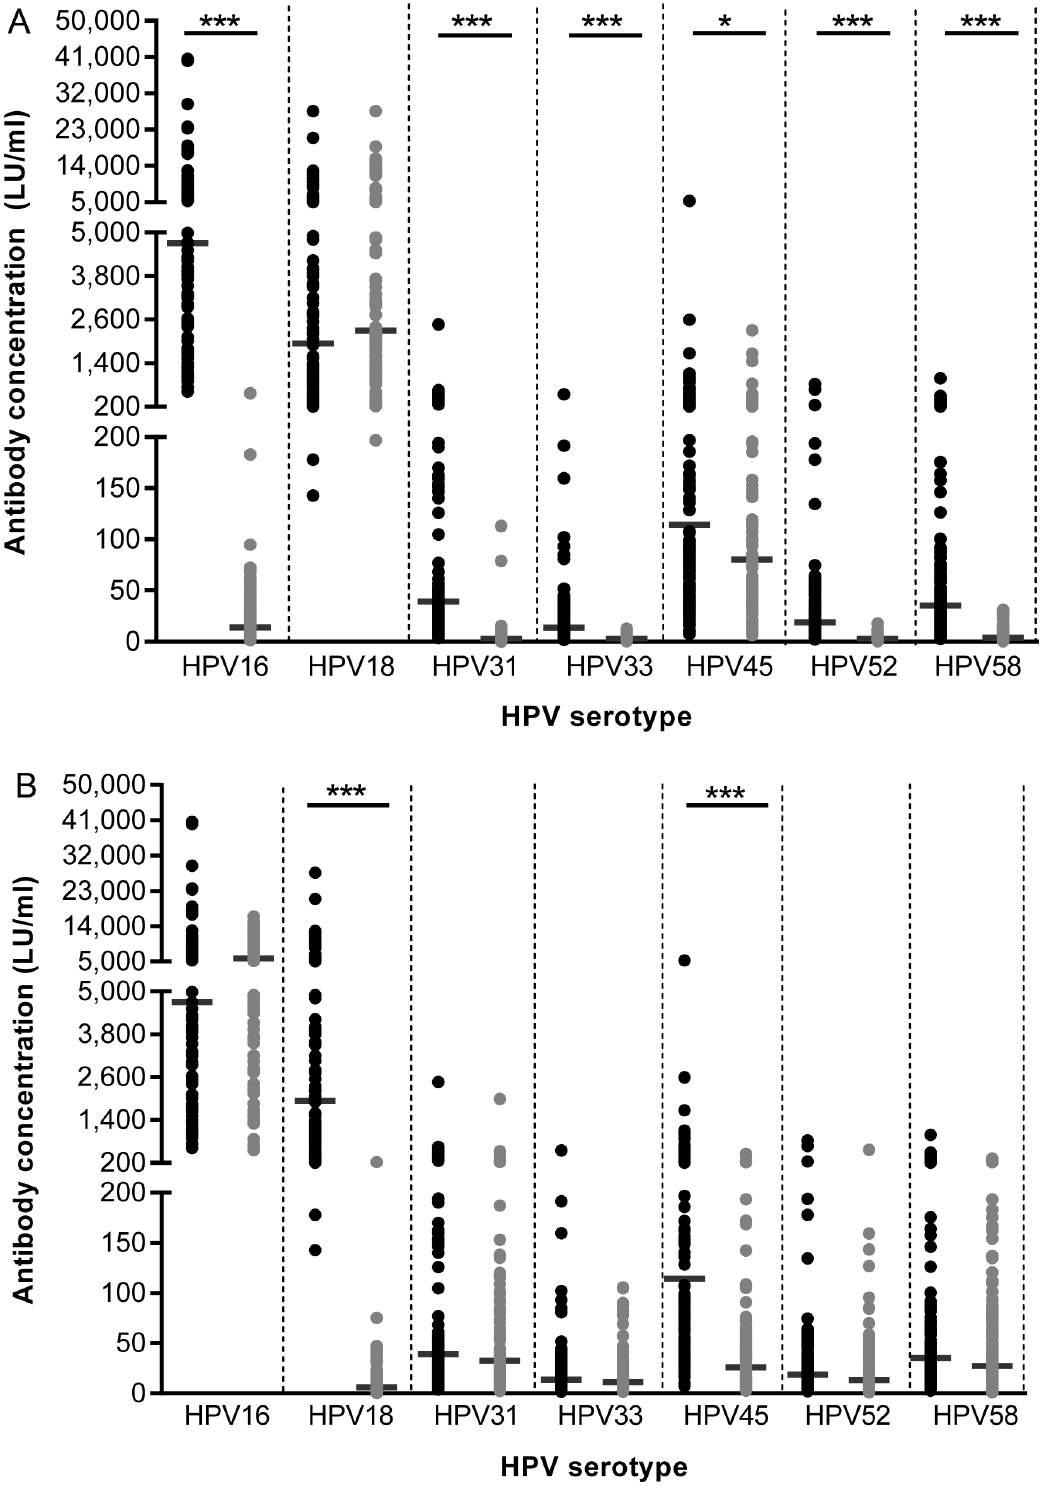
Figure 1. Inhibition of vaccine-derived HPV16 and 18 antibodies. Vaccine-derived antibody concentrations (LU/ml) pre- (dark grey dots) and post-inhibition (light grey dots) with VLP16 (A) or VLP18 (B) are shown. Dark grey lines indicate geometric mean concentrations. * p =0.05, *** p <0.0001. doi: 10.1371/journal.pone.0074797.g001 PLOS ONE |